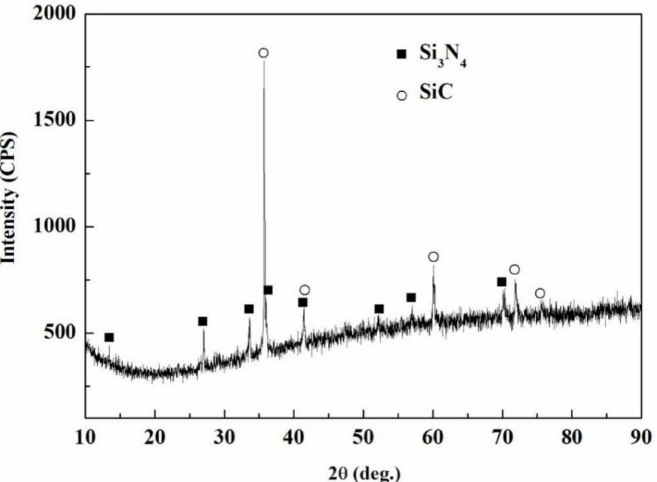
Figure 8. XRD patterns of the carbon-coated welded joint bonded with the SiCo38 alloy at 1340 ◦ C for 10